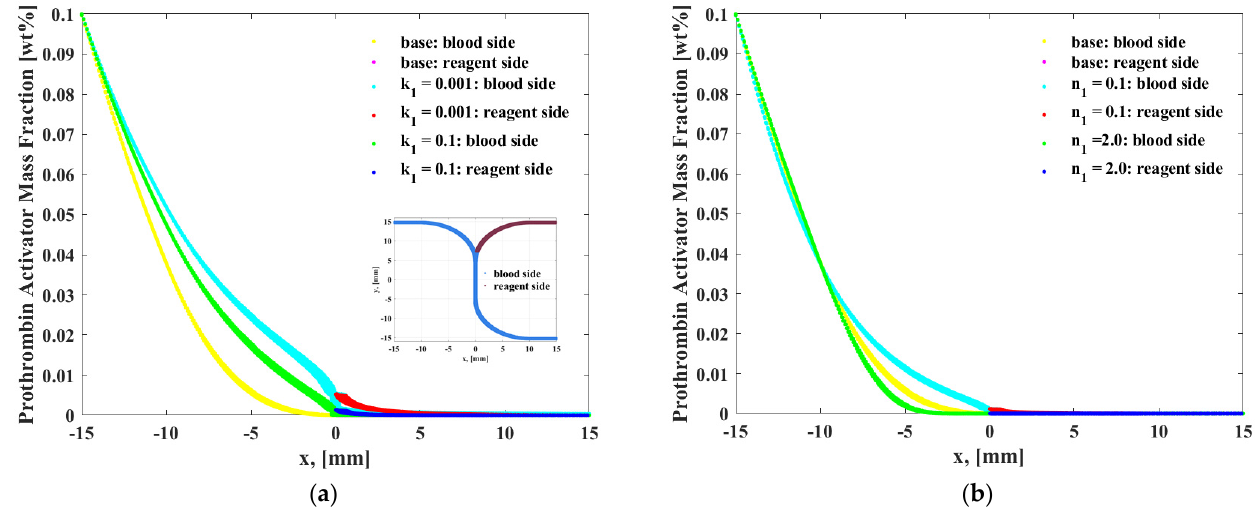
Figure 3. Distribution of the mass fraction of the prothrombin activator for ( a ) various k 1 and ( b ) n 1 .